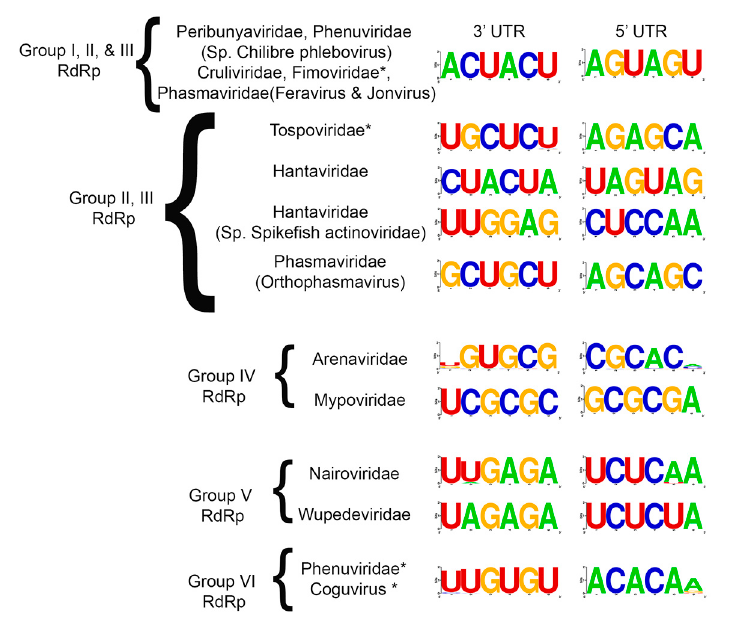
Figure 7. Consensus nucleotide sequence of the 3 (cid:48) and 5 (cid:48) termini for each genomic segment of Bunyaviriales. The consensus sequences were generated using the 6 most distal nucleotides on each end of the viral genomic segments. Each of the analyzed regions was located within a UTR. Families that contain plant viruses are highlighted with an